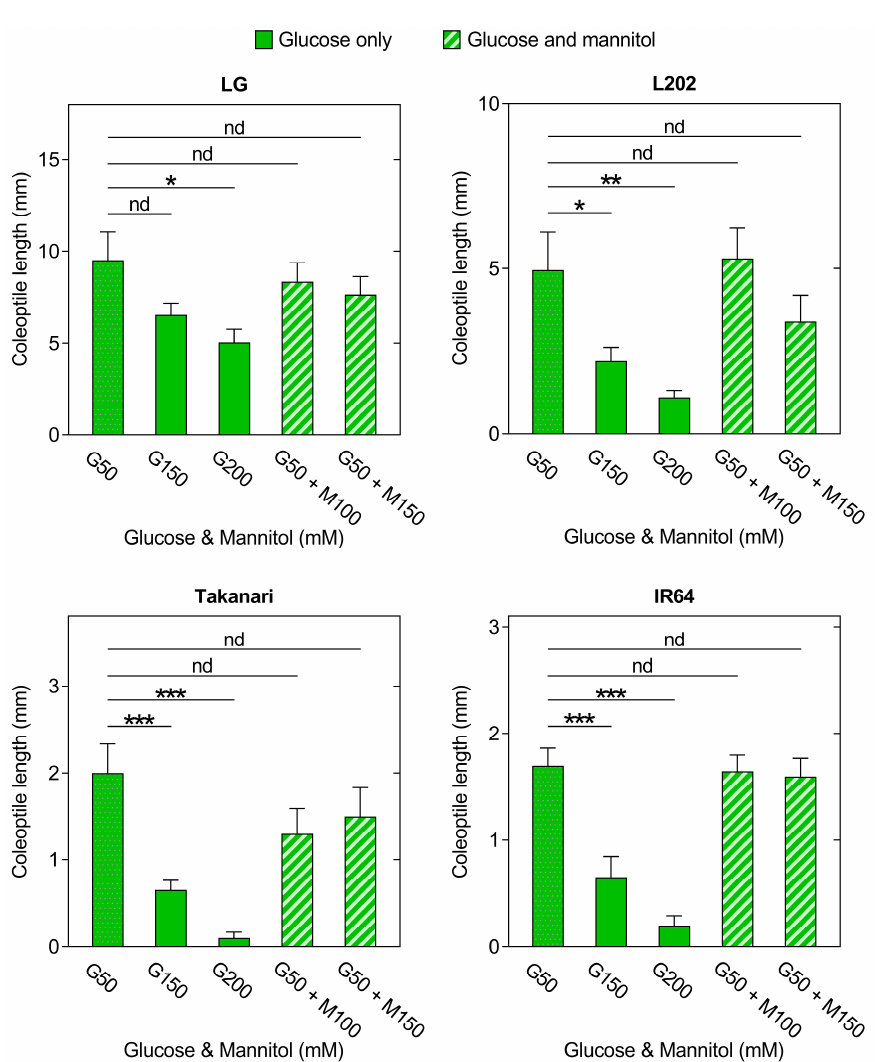
Figure 7. Evaluation of the osmotic effect on glucose-induced suppression of coleoptile elongation under oxygen deprivation in endosperm-less seeds of rice varieties with and without anaerobic germination tolerance. The endosperm of each seed was removed and incubated under 12 h light and 12 h dark cycles for 5 days in deoxygenated water containing glucose or glucose + mannitol. Data represent means ± SE ( n = 20). Asterisks indicate a significant difference between two data sets indicated by a line (* p < 0.05, ** p < 0.01, *** p < 0.001; t -test). nd, no significant difference; G, glucose; M, mannitol.